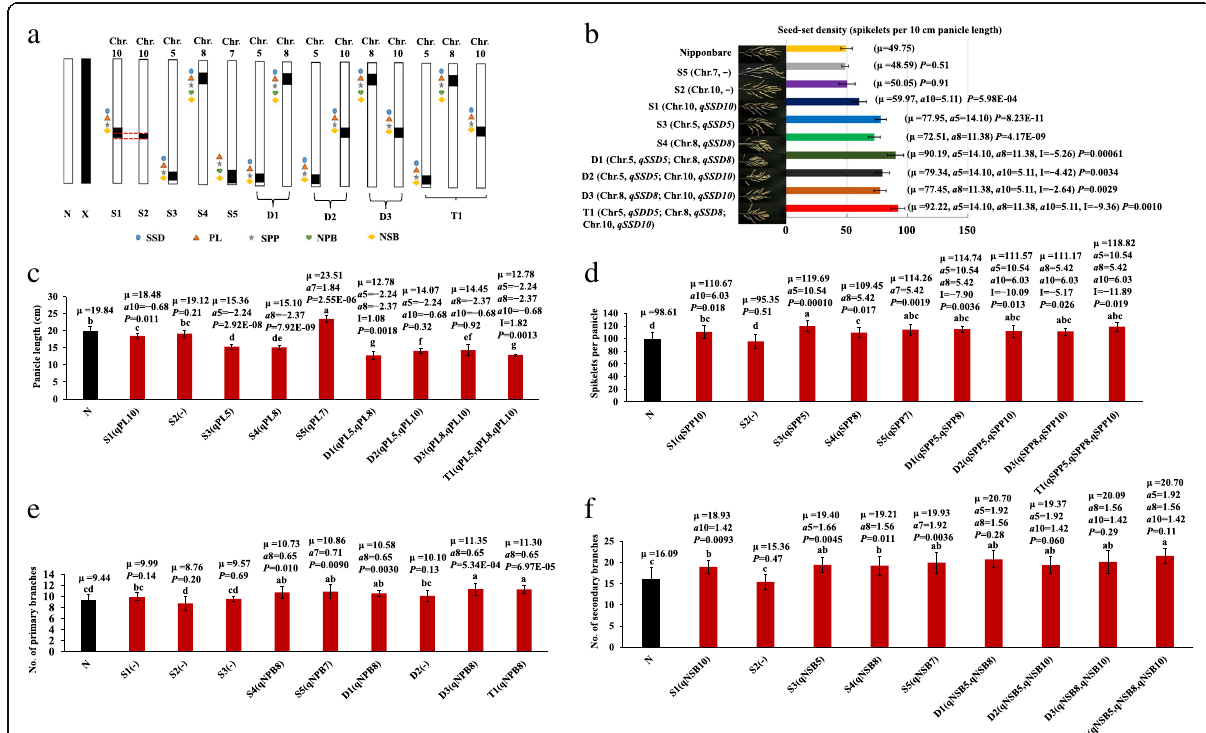
Fig. 4 Analysis of additive and epistatic effects of QTLs for seed-set density and associated traits in S1-S5, D1-D3 and T1. a Sketch map of developed SSSLs (S1-S5), DSSLs (D1-D3) and TSSL (T1). N denotes recipient Nipponbare; X denotes donor Xihui18; S: SSSL, D: DSSL, T: TSSL. b Seed-set density (SSD); c panicle length (PL); d Spikelets per panicle (SPP); e Number of primary branches (NPB); f Number of secondary branches (NSB). Different lower- case letters indicate a significant difference ( P <0.05) as determined by Duncan ’ s multiple comparisons. µ is the mean value, a i denotes the additive effect of QTLs, I denotes the additive × additive epistatic effect between QTLs. The P -value for a SSSL indicates the probability of a significant difference between the SSSL and Nipponbare, and the SSSL carried a QTL (Student ’ s t-test, p <0.05). The P -value for a DSSL and TSSL indicates the probability of an epitatic effect between QTLs in the DSSL or TSSL, i.e., (Nipponbare+DSSL ij ) and (SSSL i and SSSL j ), and (Nipponbare+Nipponbare+TSSL ijk ) and (SSSL i and SSSL j + SSSL k ) (Student ’ s t-test, p <0.05). S1:RM5348 – RM8207-RM3311 – RM4455 (Chr.10); S2: RM8207 – RM3311 – RM4455 (Chr.10); S3: RM3321